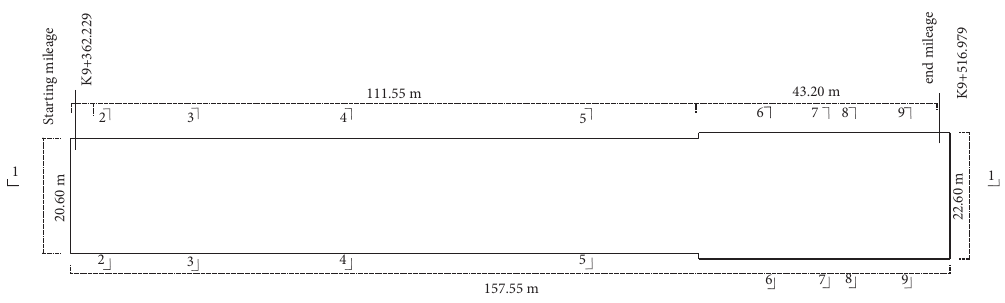
Figure 13: Plan of deep foundation pit of station main